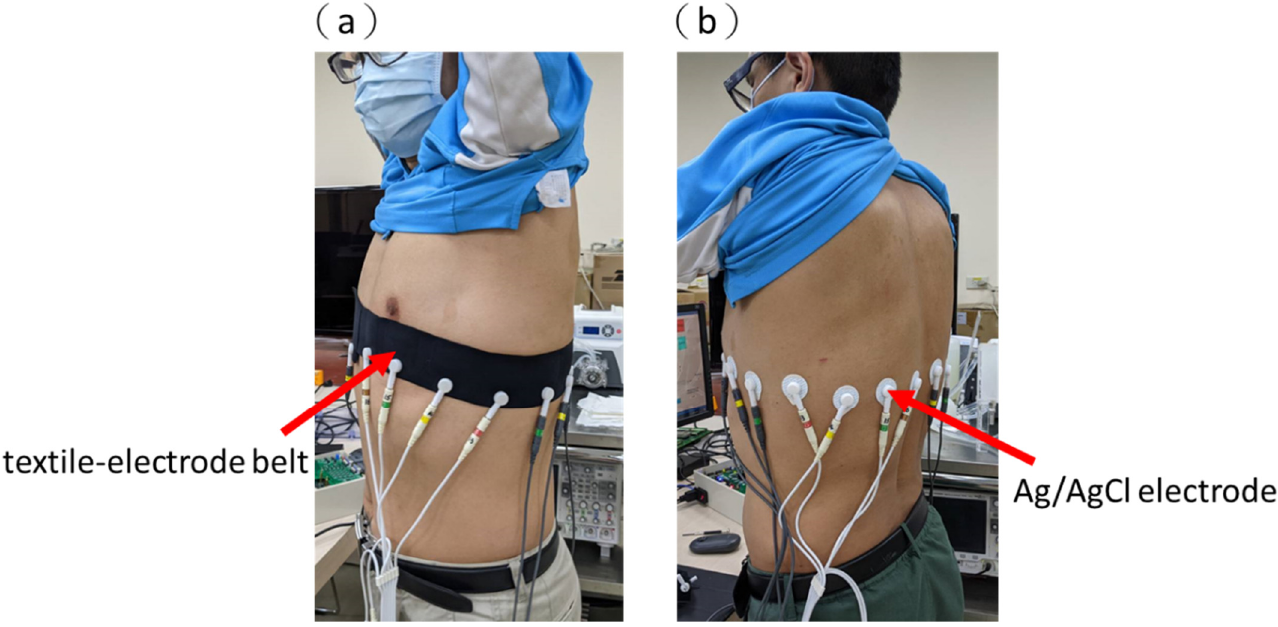
Figure 4. In vivo experiment setup. ( a ) The wearable textile-electrode belt. ( b ) Sixteen commercial electrocardiogram elec- trodes.